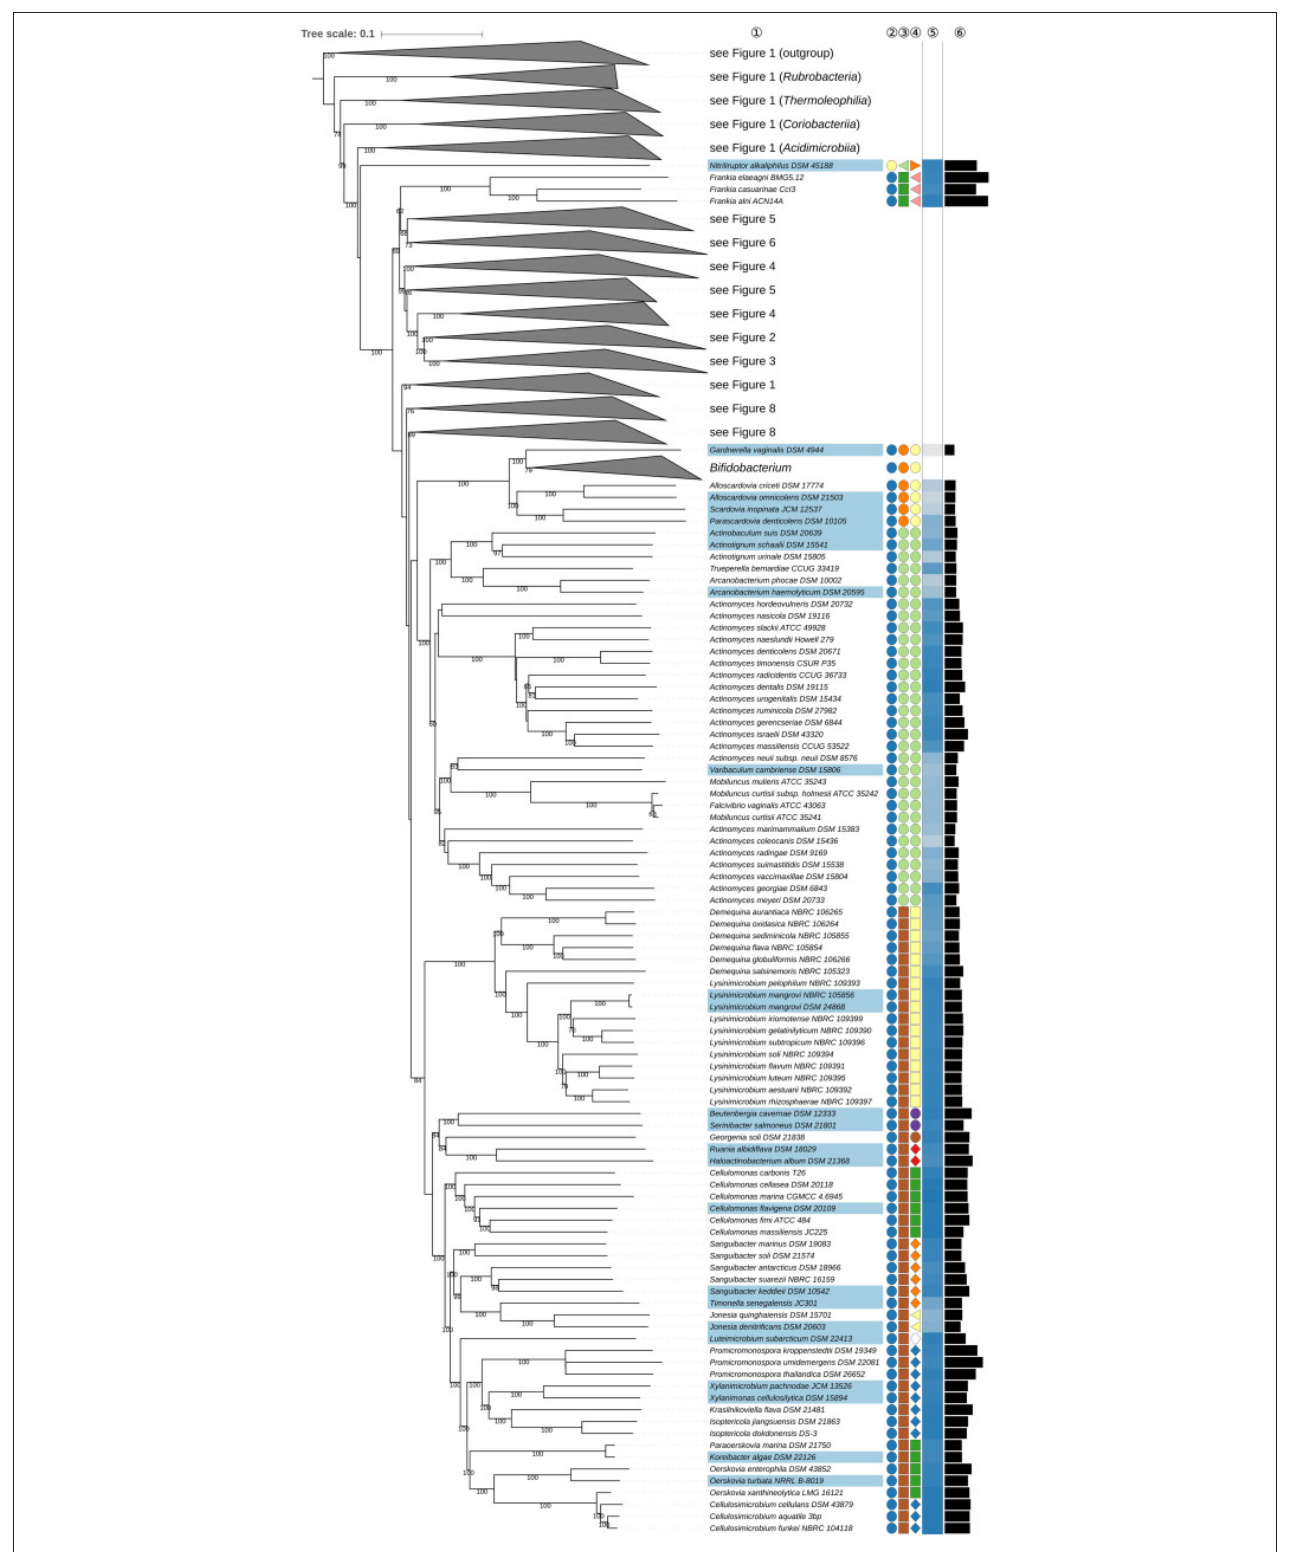
FIGURE 7 | Seventh part of the phylogenomic tree inferred with GBDP. A detailed description is provided in the caption of Figure 1 . The parts of the tree which have been collapsed here are shown in other figures as indicated.